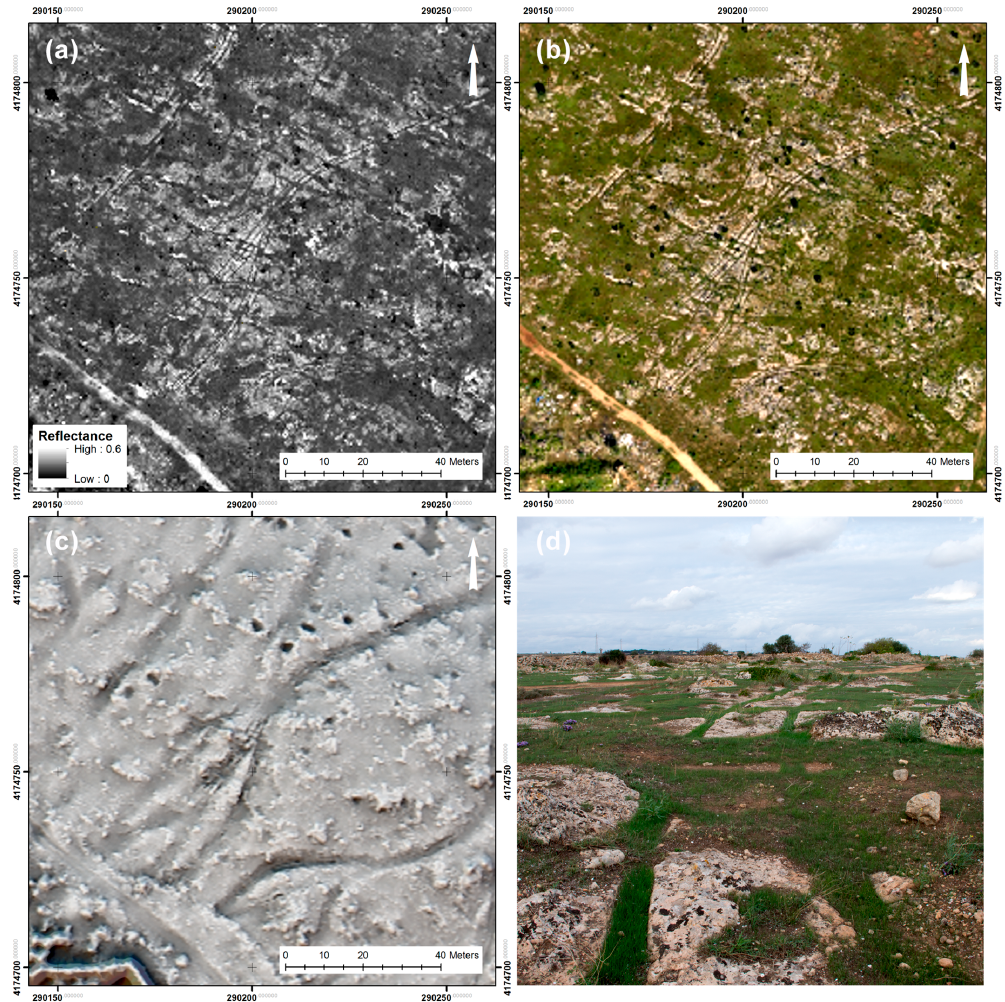
Figure 11. Cart tracks made by animal-drawn vehicles. ( a ) 50 cm spatial resolution contrast stretched calibrated reflectance image of track network; ( b ) 50 cm spatial resolution contrast stretched RGB image of track network; ( c ) multiple visualization (Multi hillshade, Simple Local Relief Model, Sky-view factor) of a 50 cm spatial resolution DTM specifically filtered to preserve archaeological structures; ( d ) ground image of one of the more ephemeral cart track pairs. Note that while the DTM visualization depicts the general outline of the deeper features in the network, the individual tracks for all but the deepest of the features are only visible in the reflectance and RGB images. Coordinate system ( a – c ): WGS84 UTM Zone 33N. Photograph ( d ): C.